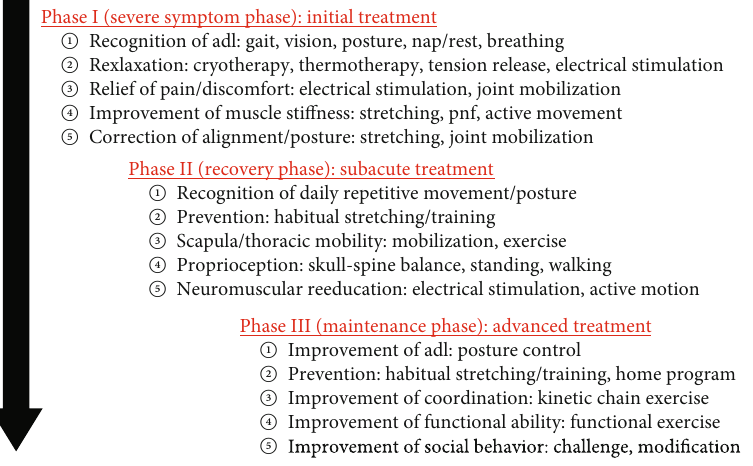
Figure 3: The principle of our approach to cervical disorders in athletes.